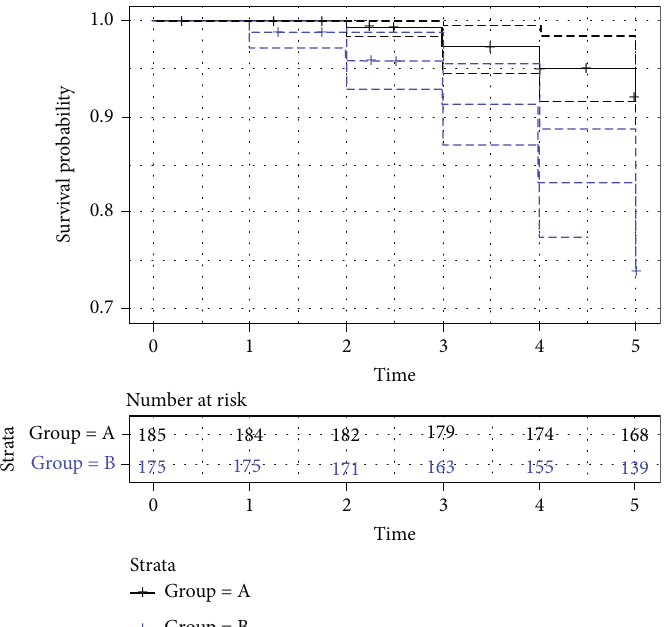
Figure 1: Kaplan – Meier survival analysis of progression to DR in Group A and Group B. The survival probability plot showed a signi fi cant di ff erence ( p value 2 : 21 × 10 − 5 ) in the two